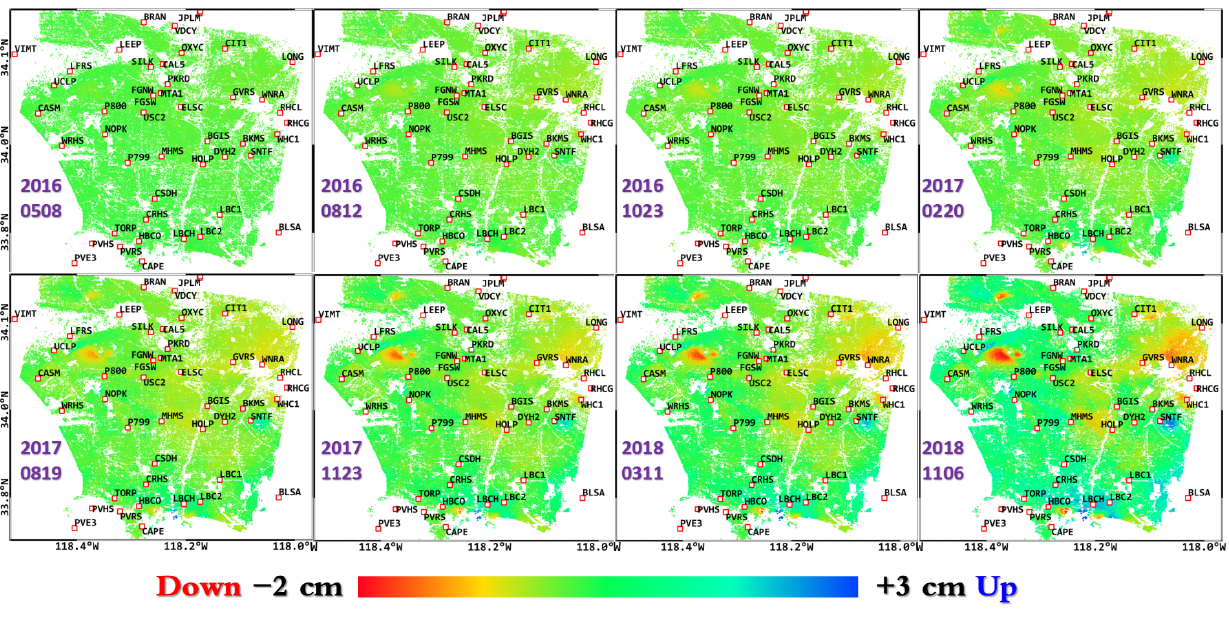
Figure 11. Up–down deformation time series maps obtained by SM-Kalman. GNSS sites are repre- sented by red